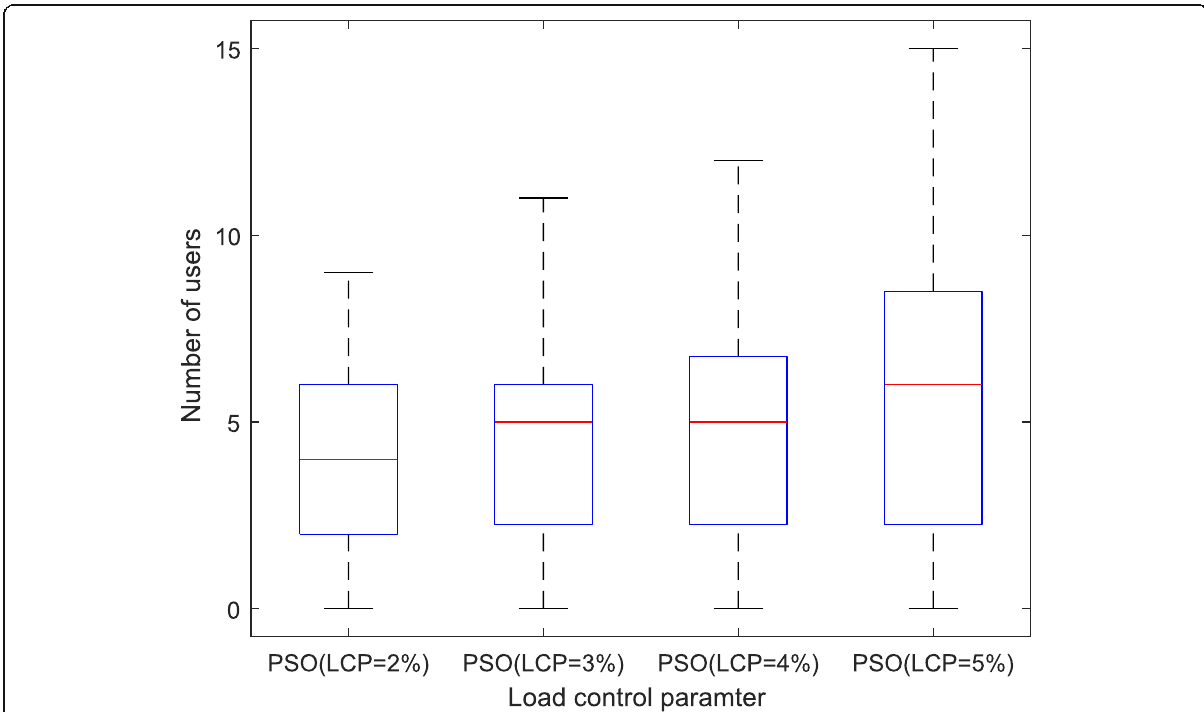
Fig. 6 Number of users per BS for different load control parameter. This figure shows the load per base station when the per base station biasing using particle swarm optimisation is implemented. It shows how particle swarm optimisation can control the number of users that are located at the cell expansion